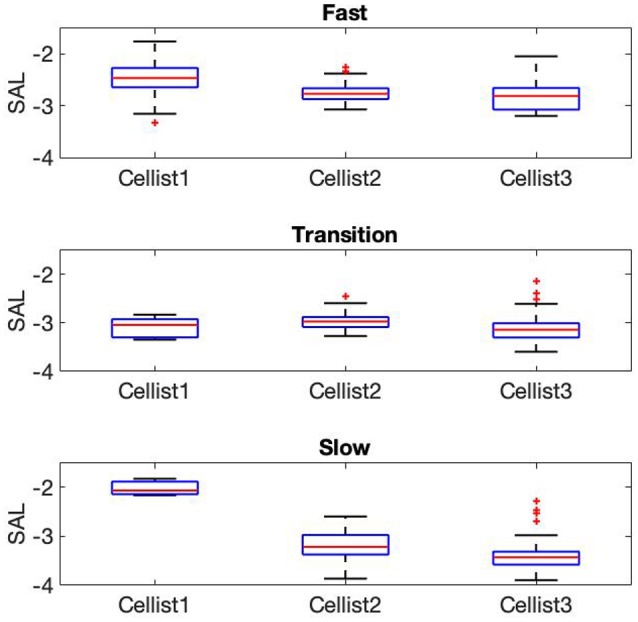
SAL metric for the three cellists computed across different phases: Fast (Top), transition (Middle), and slow (Bottom). Each box displays the range of upper and lower quartile values with the median as a red line in the middle. Whiskers are showing maximum and minimum values.